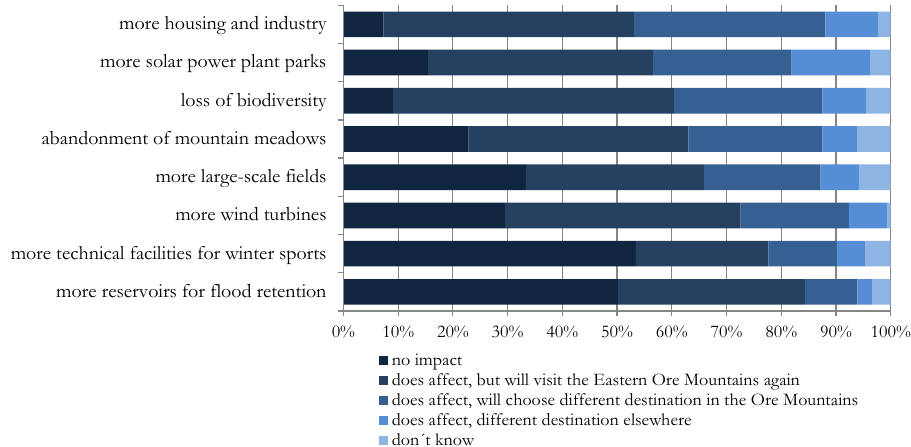
Figure 7: Impact of landscape changes on choice of destination for tourism/ recreation (external visitors’ view, n=288 )